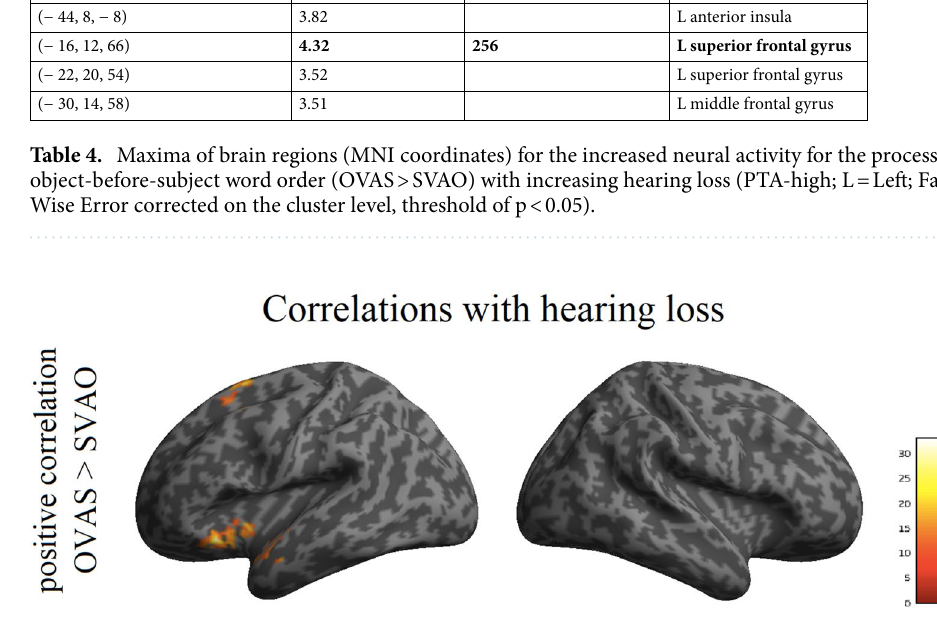
Figure 3. Neural activity associated with hearing loss. Increased neural activity for the processing of object- before-subject word order (OVAS > SVAO) with increasing hearing loss (PTA-high; Family-Wise Error corrected on the cluster level, threshold of p < 0.05). Inflated brain images were created with SPM12 (http://www.fil.ion.ucl. ac.uk/spm); the colors reflect the F values from the